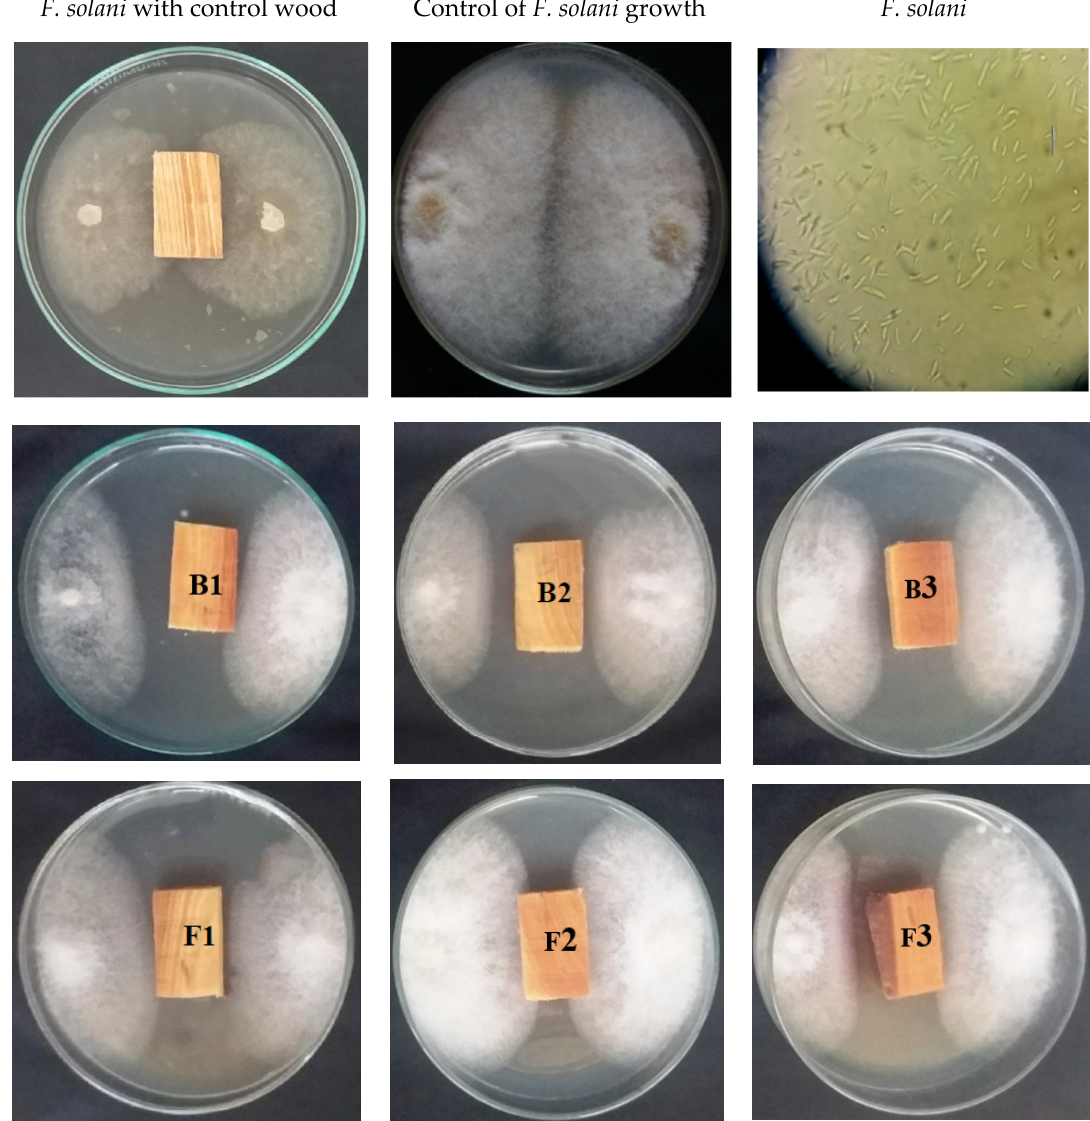
Figure 3. Antifungal bioassay of wood treated with (B) P. halepensis OLE and (F) S. terebinthifolius EO against the growth of F. solani . B1: 3%; B2: 2%; B3: 1%; F1: 3%; F2: 2%; F3: 1%.